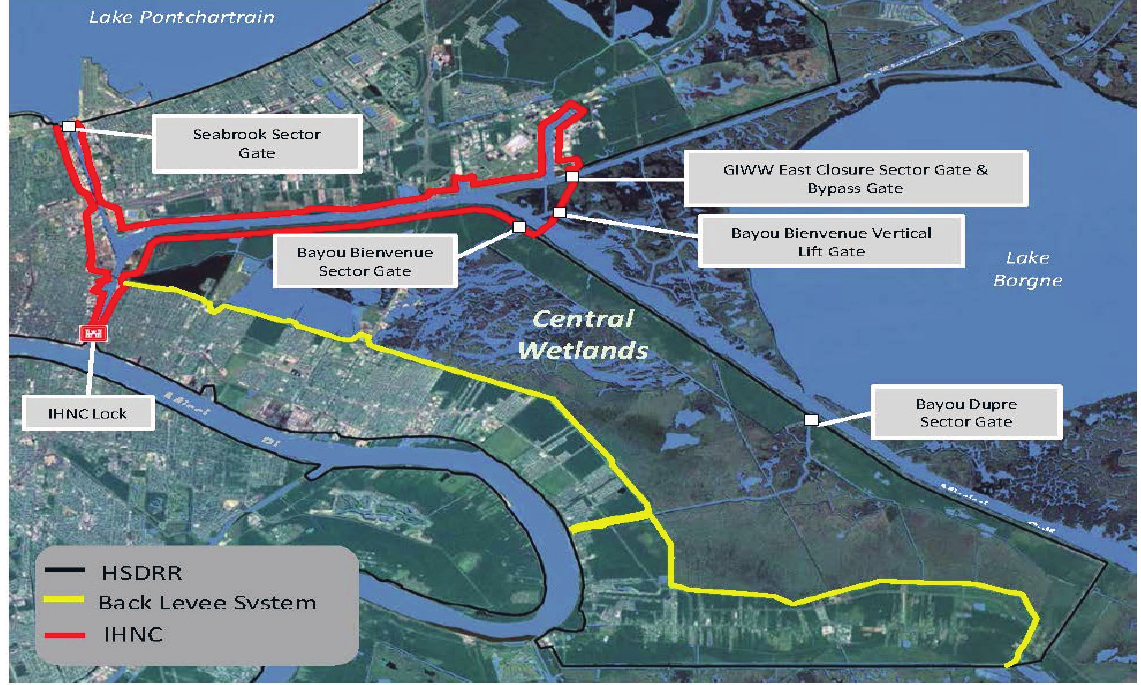
Figure 8. Location map of the IHNC-LBSB, IHNC floodwalls and the Central Wetlands. The surge barrier design was based on detailed modeling of wind, surge, waves and rainfall for 152 synthetic storms that were selected to span the historical record of storms that have impacted southeastern Louisiana. Responses from this limited storm set were then interpolated to a much larger storm set to represent the full range of possible storm conditions and to enable recurrence analysis. The final 8 m design height (selected to minimize the impact of a 100-year, 1% chance annual occurrence event and provide resilience to a 500-year, 0.2% chance annual occurrence event) included 0.3 m of LSLR over the